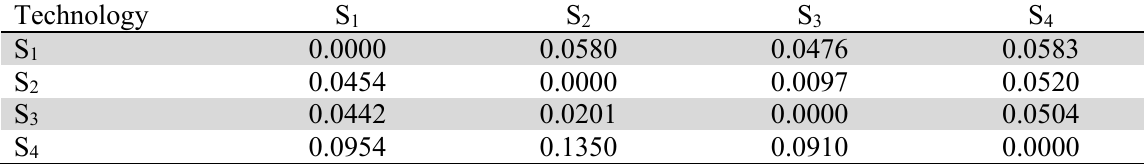
Aggregated preference performance